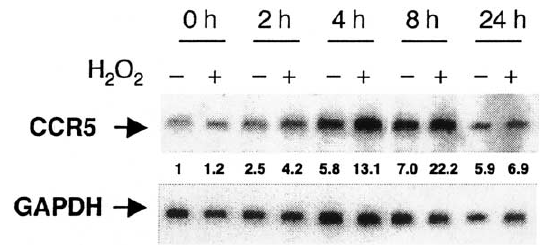
FIG. 3. Time course of H 2 O 2 -induced upregulation of CCR5 gene expression. Monocytes were incubated in the absence or presence of H 2 O 2 (200 m M) for the indicated time periods followed by northern blot analysis of CCR5 gene expression. Total RNA was then extracted and analysed by northern blot for CCR5 and GAPDH gene expression. The results are representative of two independent experiments.